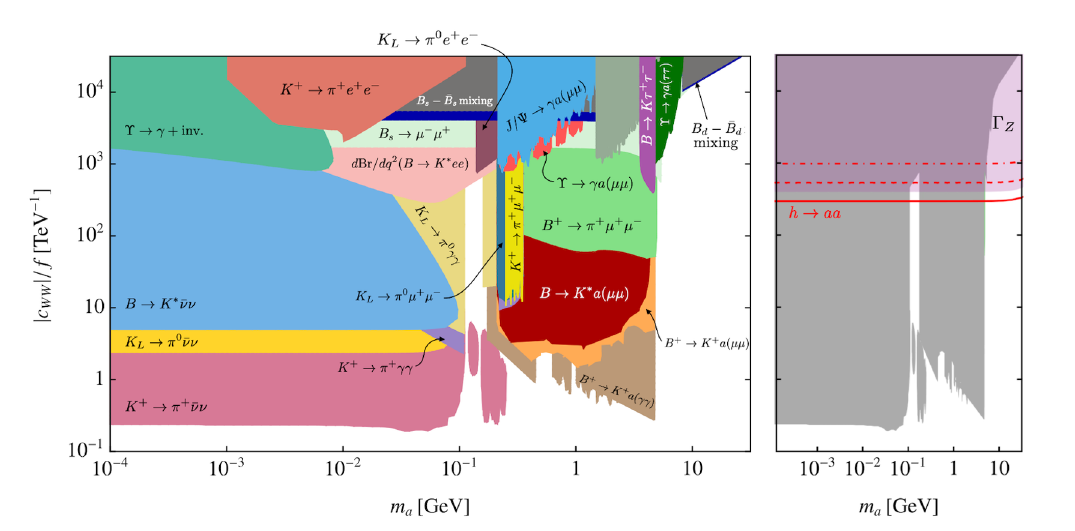
Figure 20 . Left: flavor bounds on ALP couplings to SU(2) L gauge bosons with all other Wilson coefficients set to zero at Λ = 4 πf and f = 1 TeV. Right: comparison of the same flavor constraints (light gray) with the constraints on Z → aγ decays from the LEP measurement of the Z boson width (violet) and contours of constant Br ( h → aa ) = 10 − 1 , 10 − 2 and 10 − 3 depicted as red dotted, dashed and solid